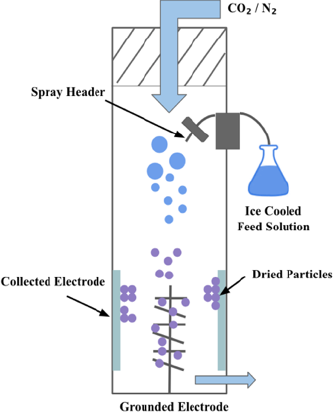
Figure 4. Nano Spray Drying—A liquid jet stream of the protein is released into a chamber using a nozzle and dried, and heated carbon dioxide and nitrogen and hollow nanospheres are collected by an electrode at the bottom of the chamber.